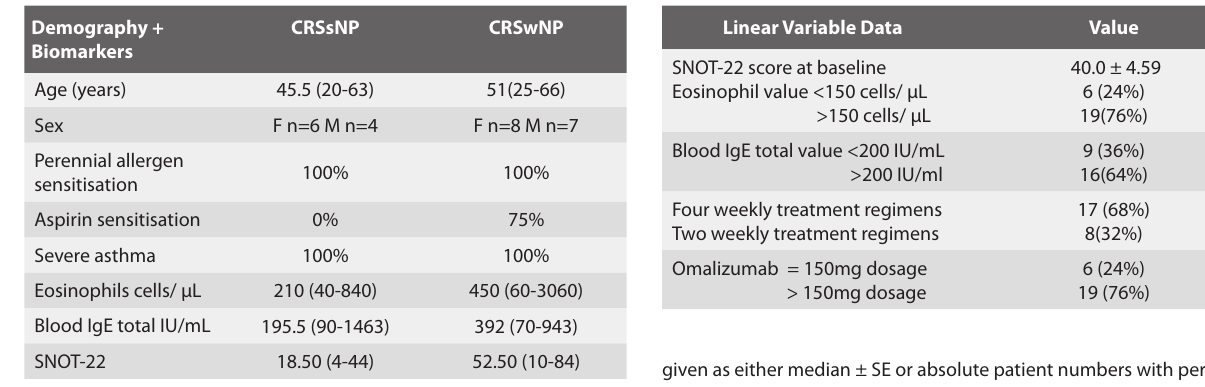
Values are stated as the median (range) where appropriate. F=female M=male.